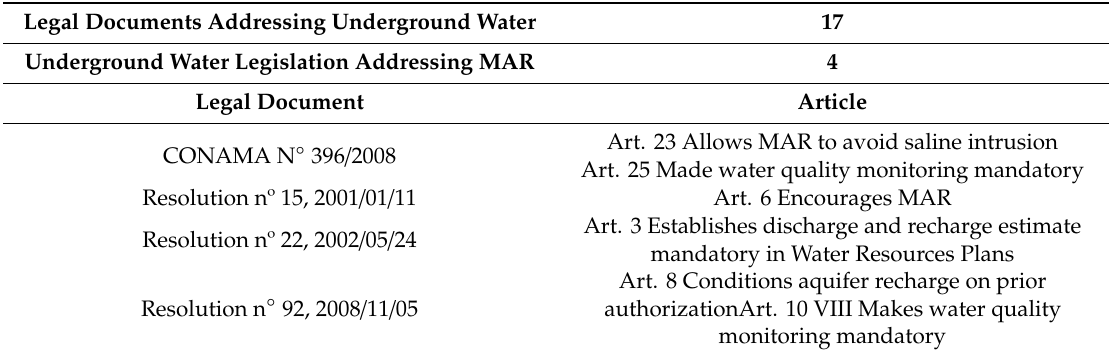
Table 2. Legal framework at the federal